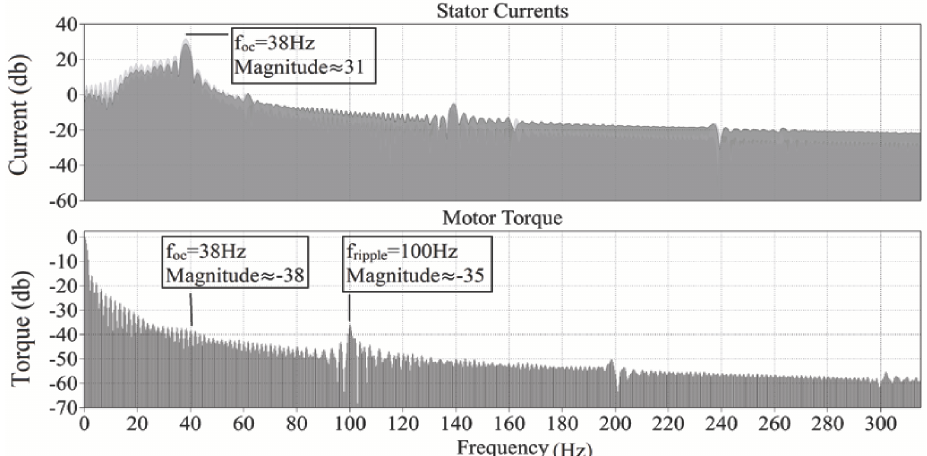
Figure 15. Frequency domain simulation depicting the low frequency components of the stator currents i abc and motor torque T e . The high frequency components of the stator currents i abc and motor torque T e are presented in Figure